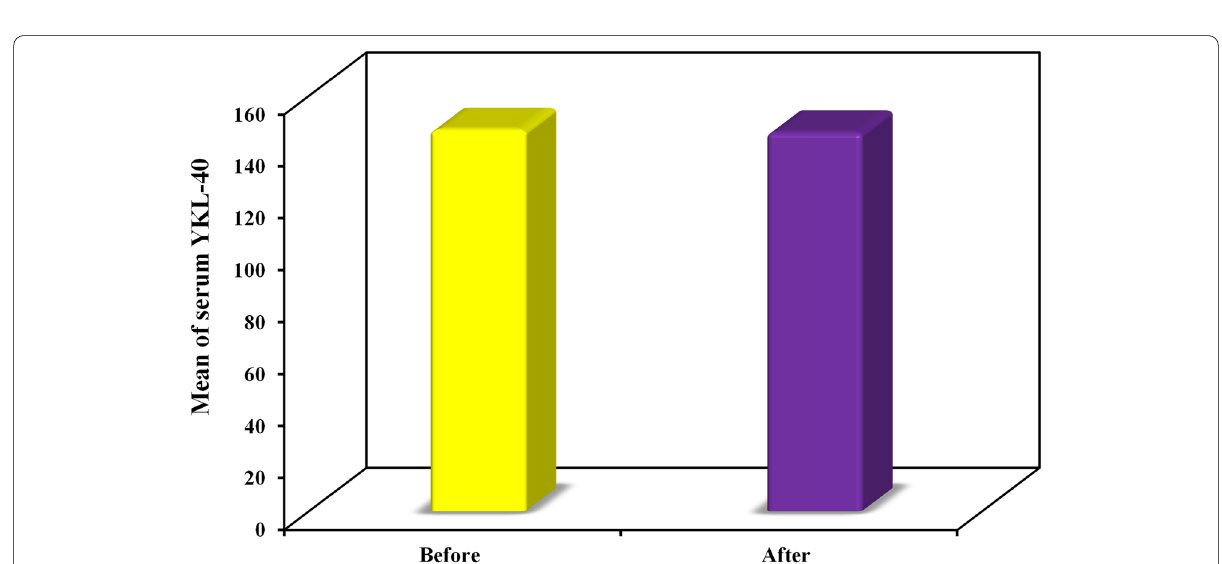
Fig. 4 Serum YKL‑40 in group IIIa and group IIIb after oesophageal varices